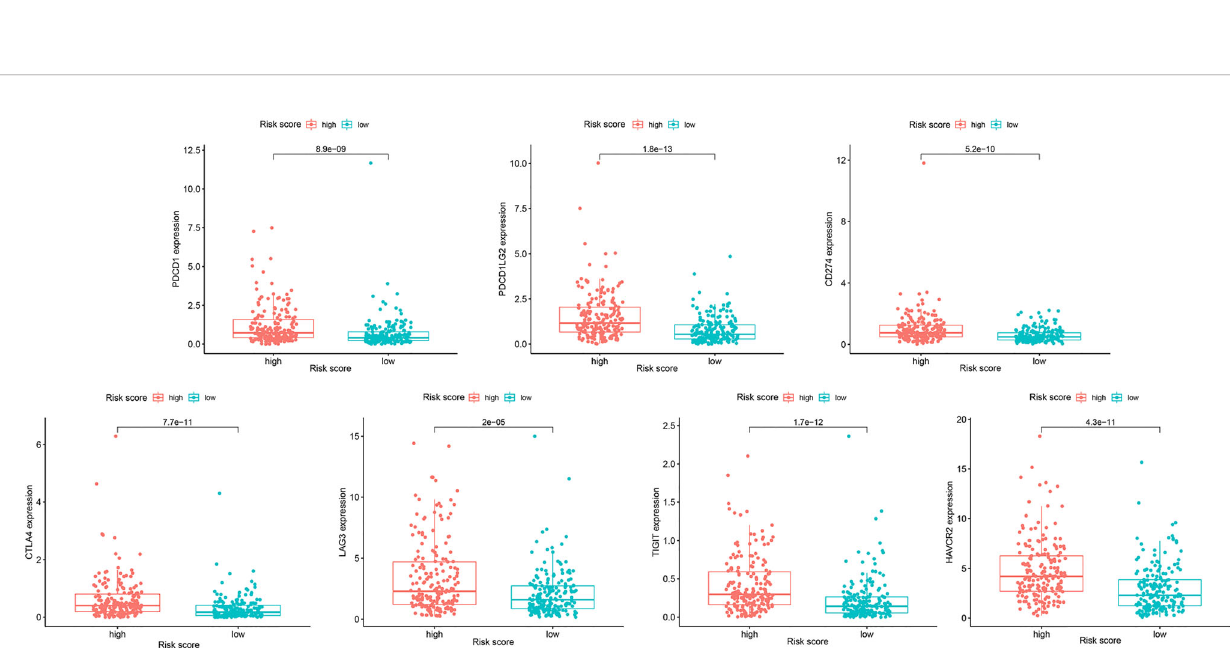
FIGURE 9 | The expression differences of 7 immunosuppressive checkpoint genes in HRG and LRG.